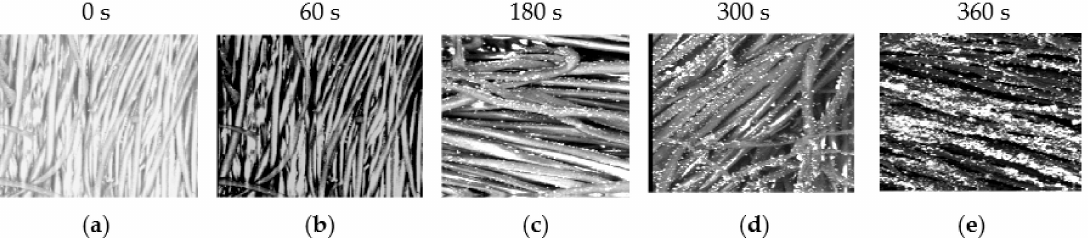
Figure 6. SEM micrographs of the cotton fabric samples before and after APPJ sputtering treatment: ( a ) controlled sample without treatment, ( b ) sample treated with dry Ar-APPJ for an exposure time of 60 s; ( c – e ) samples treated with wet Ar-APPJ for an exposure time of 180, 300, and 360 s, respectively.